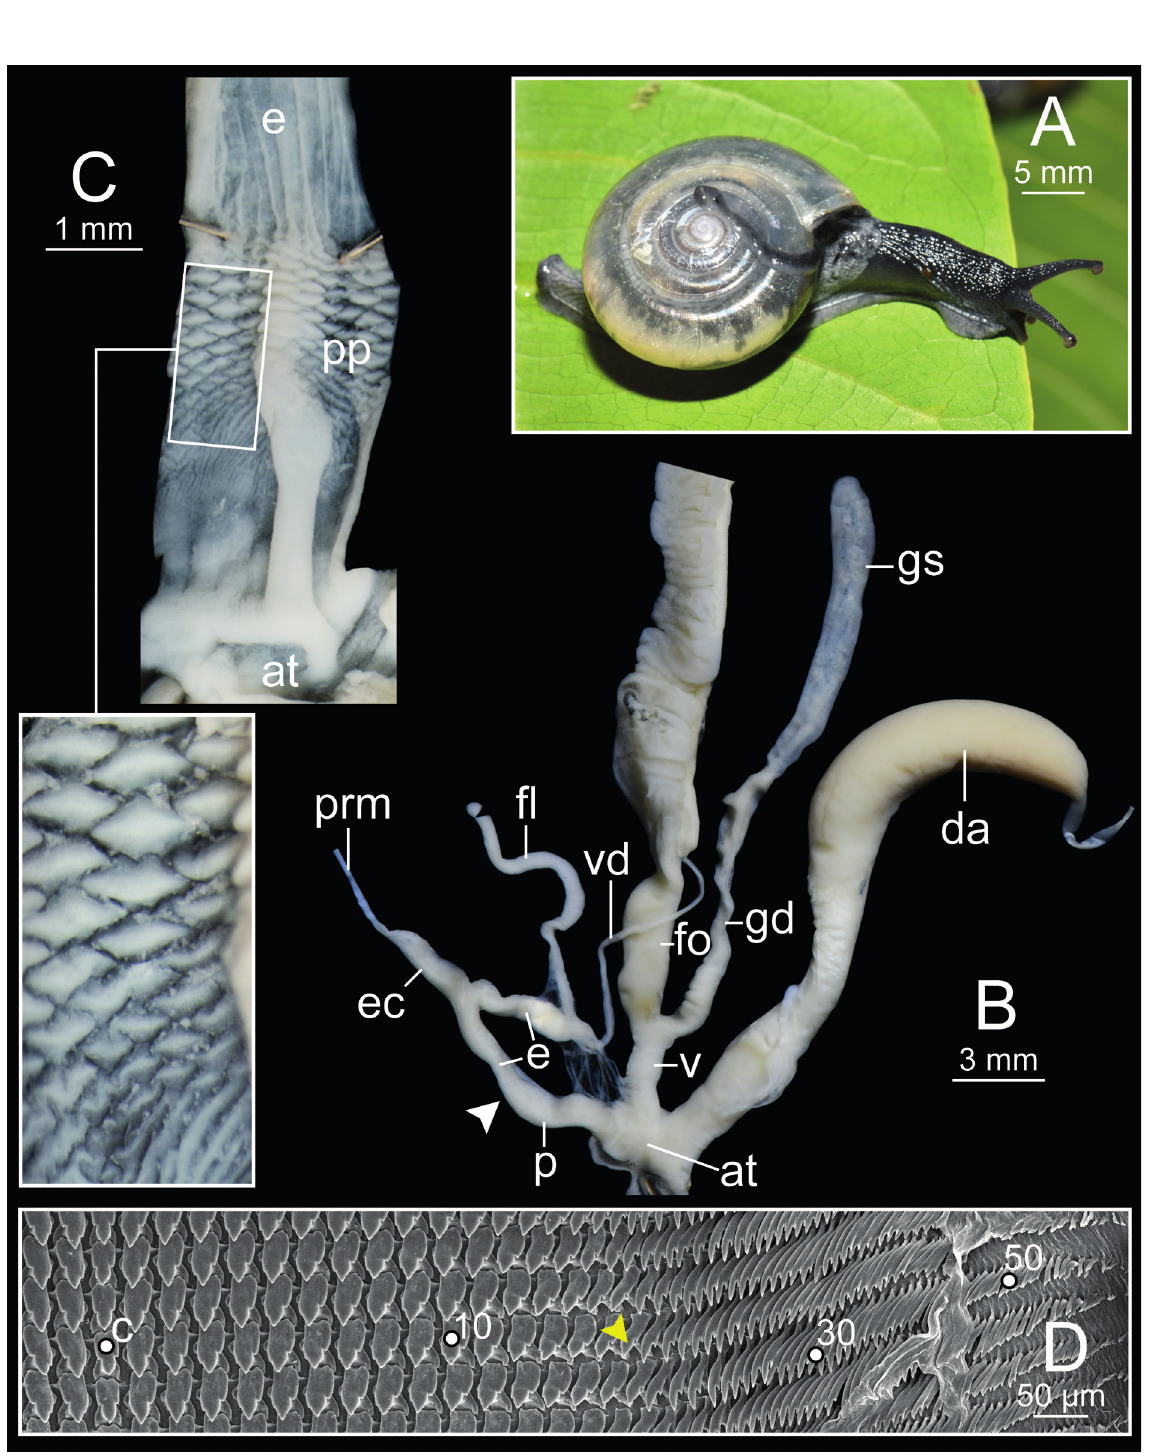
Fig. 3. Sarika lactoconcha Pholyotha & Panha sp. nov., paratype (CUMZ 7902). A . Living snail. B . General view of genital system. C . Internal structure of penis. D . Representative SEM image of the radula. Central tooth indicated by ‘C’; yellow arrow heads indicate lateral teeth with the transition to marginal teeth; white arrow heads indicate the end of